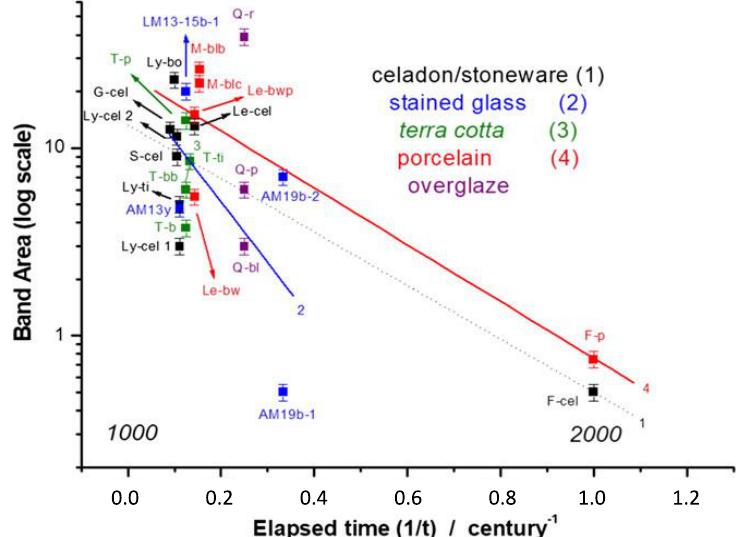
Figure 4. Arrhenius law applied to H 2 O / OH band area as a function of time passed since production date for celadons or stoneware, reference stained glasses, glazed terra cottas, porcelains, and porcelain overglazes. The groups are mapped with regression lines. (Reproduced from work in [10] with the permission of Wiley, copyright 2018.)